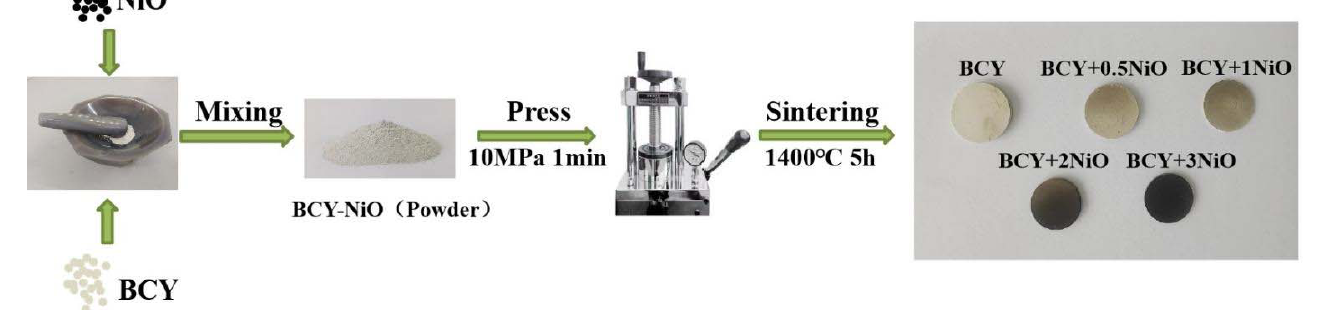
Figure 1. Schematic diagram of the BCY–NiO electrolytes